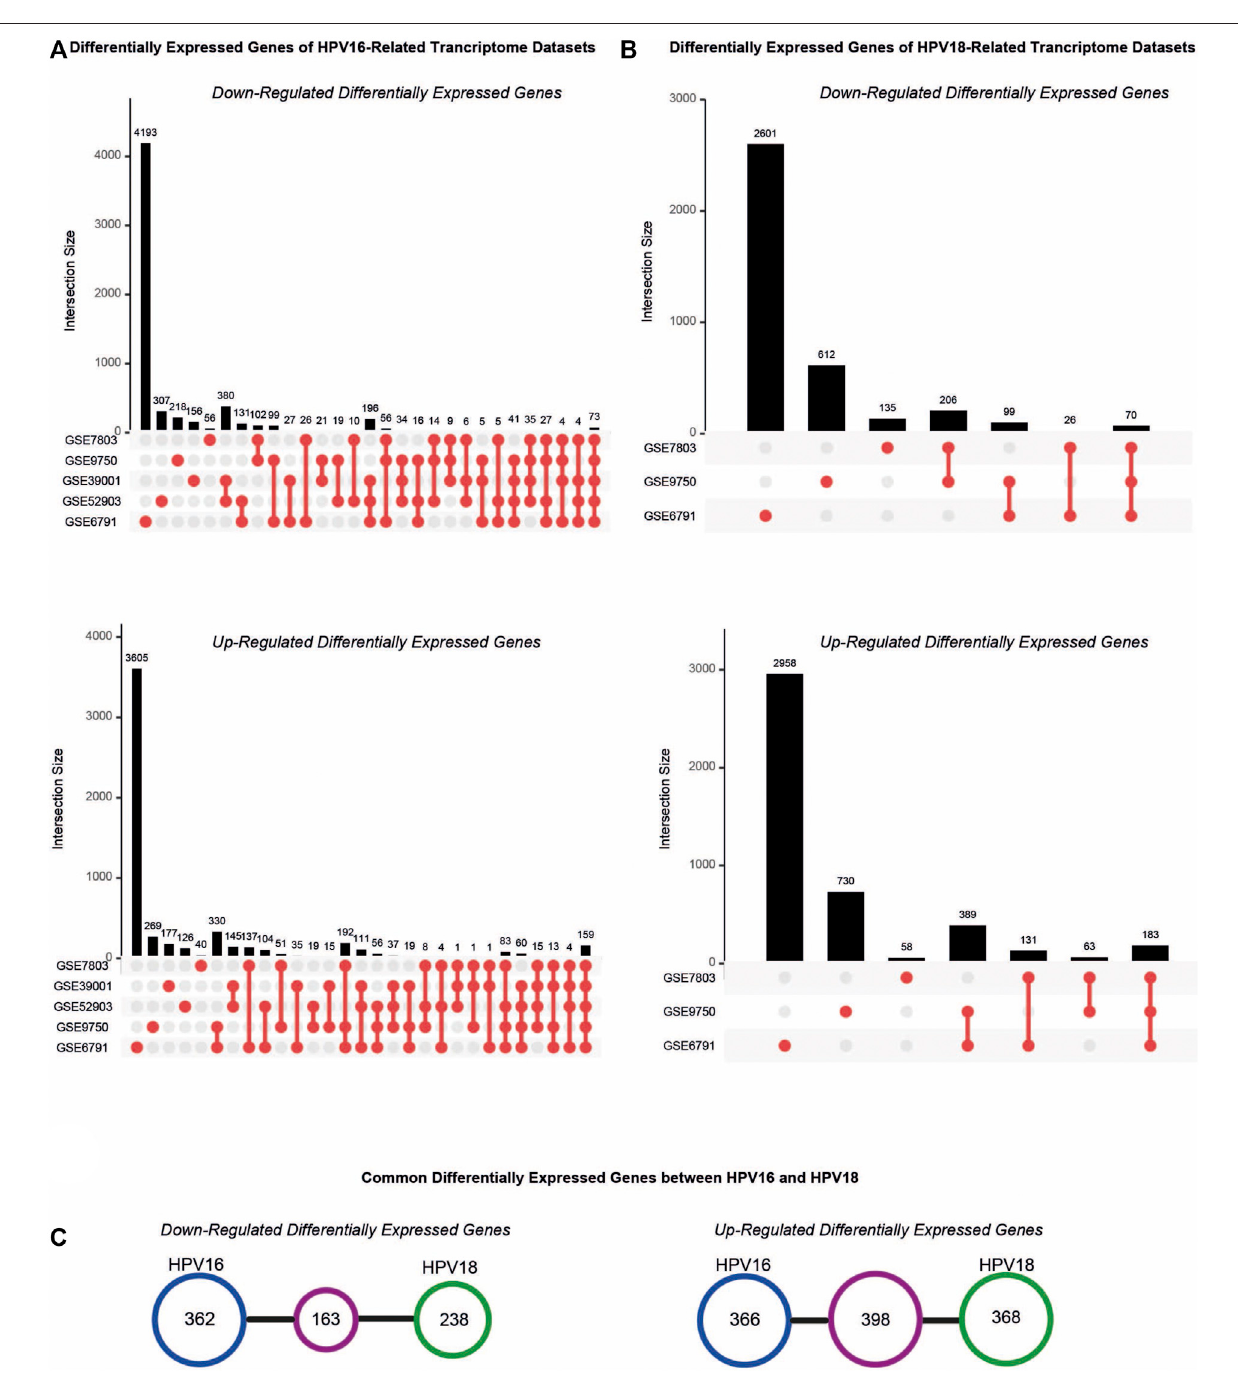
FIGURE 2 | The distribution of differentially expressed genes (DEGs) in the cervical cancer transcriptome datasets. (A) The upset plots represent DEGs in the transcriptomedatasetsthatcompromisedHPV16cervicalcancersamples. (B) TheupsetplotsrepresentDEGsinthetranscriptomedatasetsthatcompromisedHPV18 cervical cancer samples. (C) The diagrams represent the common DEGs in the HPV16- and HPV18 transcriptome datasets.